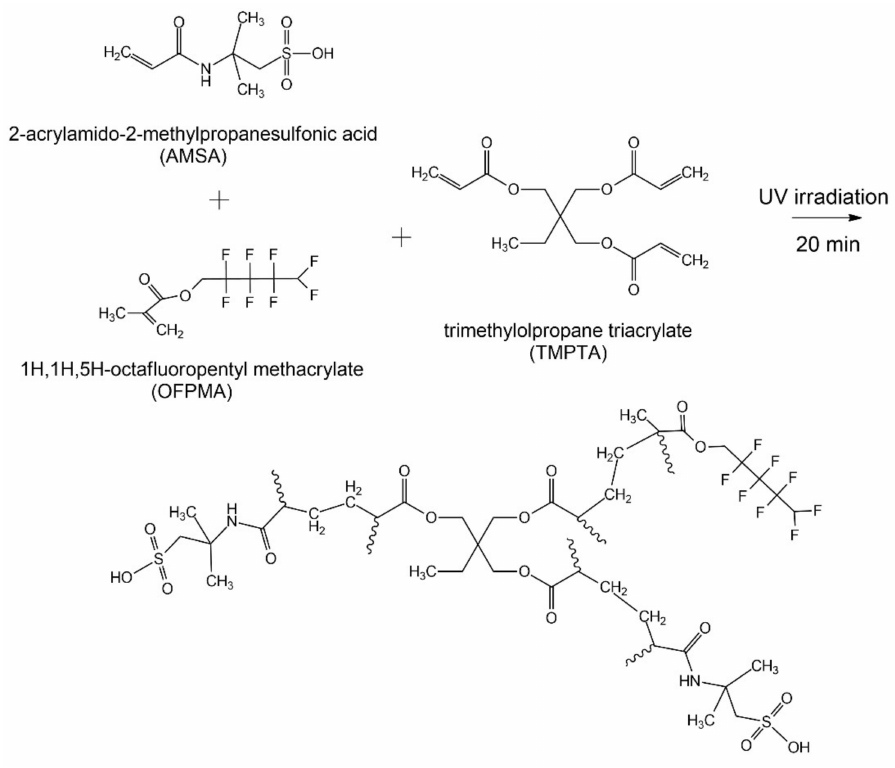
Figure 1. Reaction scheme of the cross-linked proton-exchangeable polymer containing fluorinated moiety.